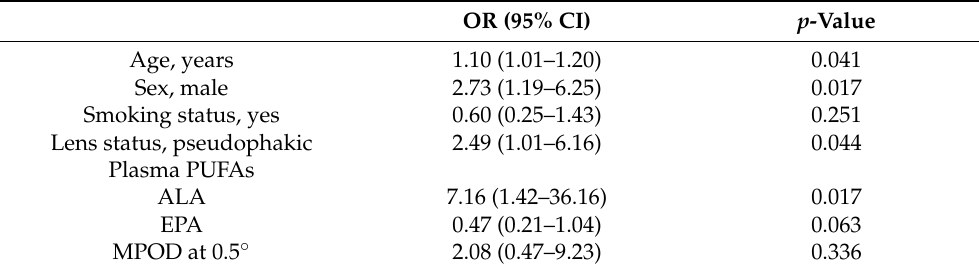
Table 4. Multivariable analysis of association between MPOD at 0.5 ◦ and the presence of primary open-angle glaucoma in the Montrachet